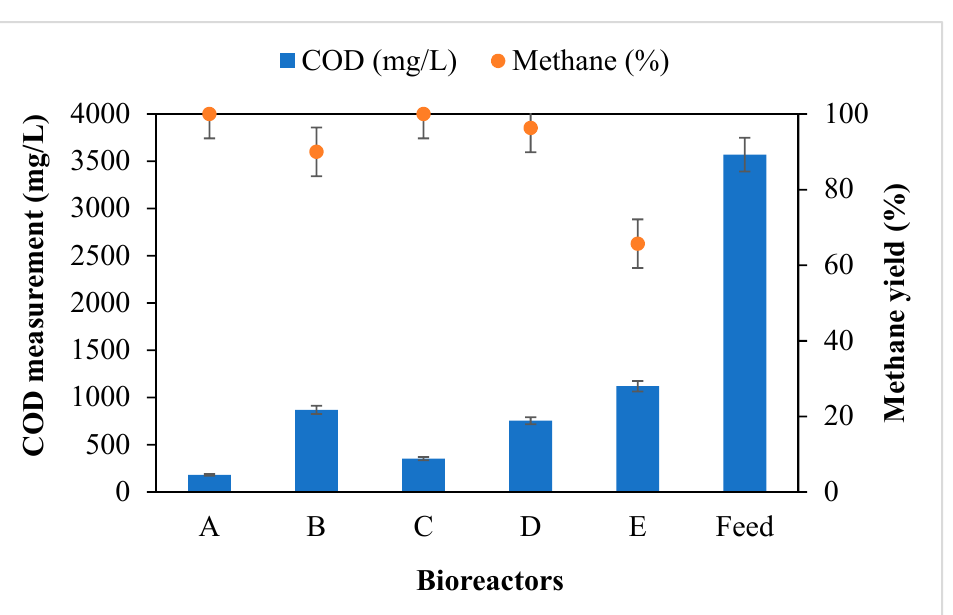
Figure 5. COD measurement and methane yield of bioreactors A–D charged with 2 g of ( A ) Fe 2 O 4 - TiO 2 ; ( B ) Cu-Fe 2 O 4 ; ( C ) Fe 3 O 4 ; and ( D ) Chitosan-Fe 2 O 4 /TiO 2 MNPs, whereas bioreactor E is a control: ( E ) no MNPs.